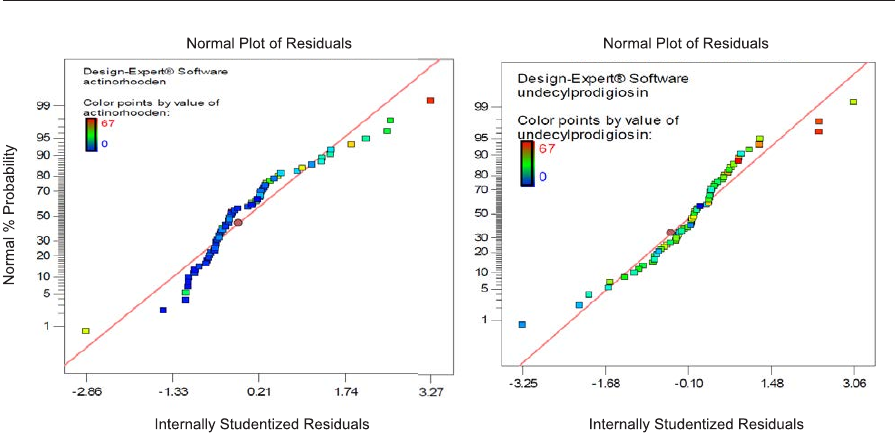
Fig. 2. Normal probability plot of standarized residual of linear L-pseudo model based on mixture simplex latic model for undecylprodigiosin and actinorhodin production by Streptomyces coelicolor